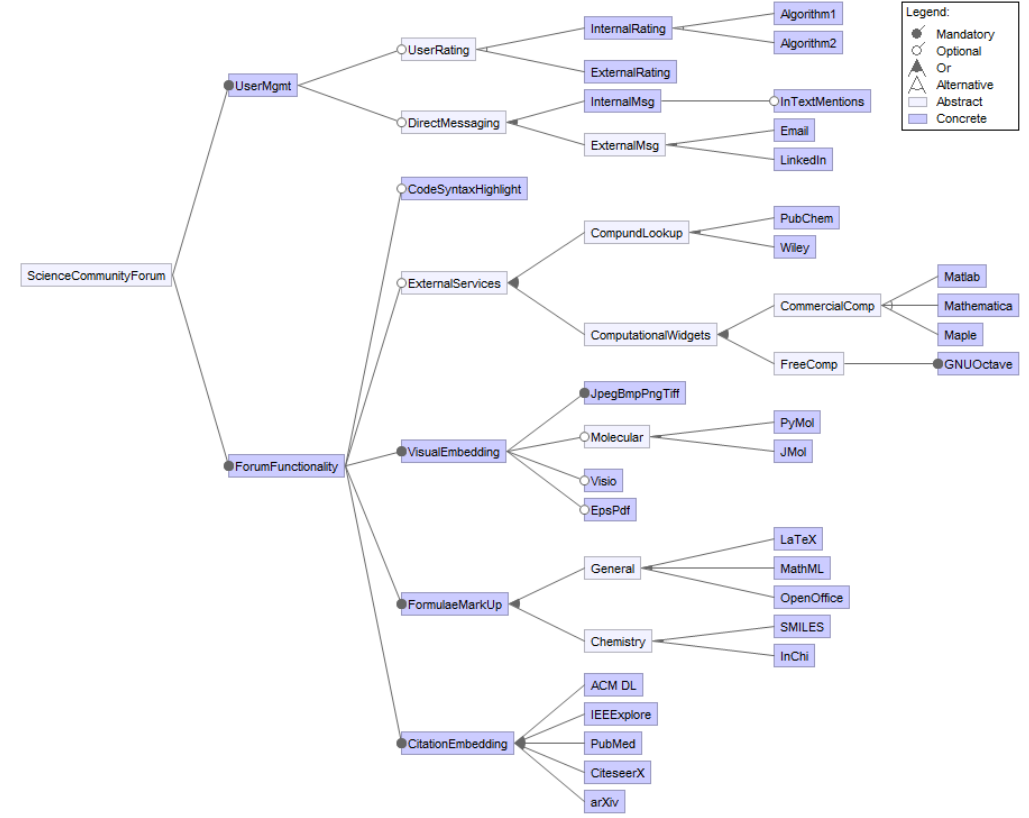
Figure 4. An example feature tree for a scientific forum software